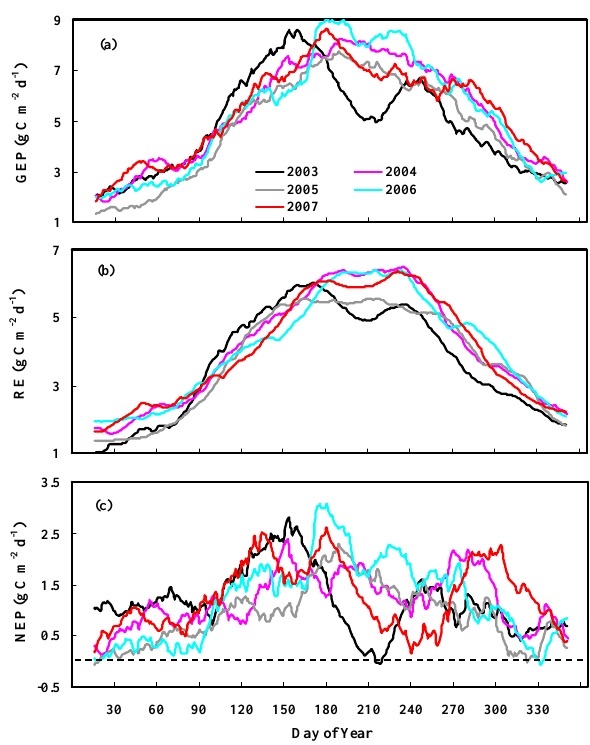
Fig. 3. Seasonal and interannual variations of 30-day running-mean (a) gross ecosystem photosynthesis (GEP), (b) ecosystem respira- tion (RE) and (c) net ecosystem production (NEP) from 2003 to 2007 at Qianyanzhou site.